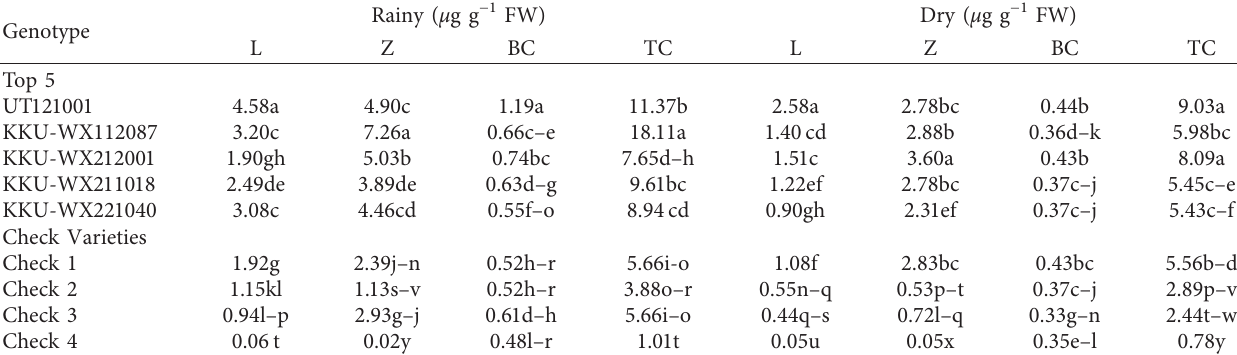
Table 4: The carotenoid profiles of top five small-ear waxy corn genotypes based on cluster analysis and four check varieties in two different seasons.